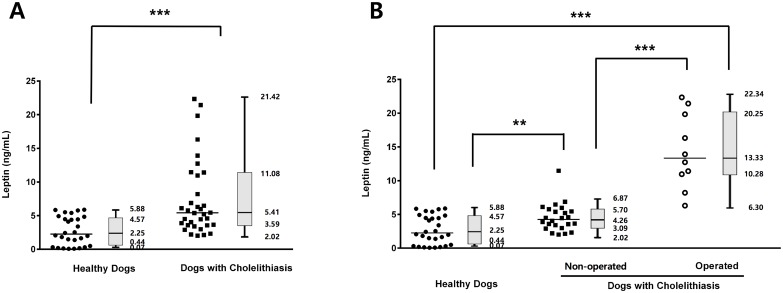
Circulating leptin levels.(A) In dogs with cholelithiasis (n = 34), serum leptin levels were significantly higher than those determined in healthy dogs (n = 28). (B) Serum leptin levels were significantly higher in cholelithiasis patients that underwent cholecystectomy compared with those in patients that did not undergo surgery. Horizontal bars in scatter plots indicate median values. **p < 0.01, ***p < 0.001 between groups.